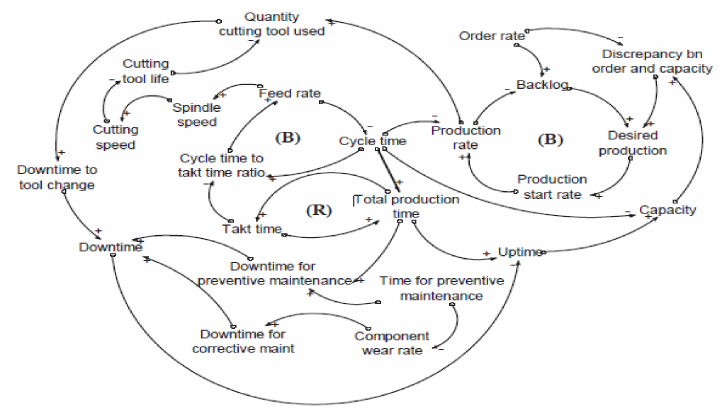
Figure 5. Causal loop diagram for the main manufacturing system